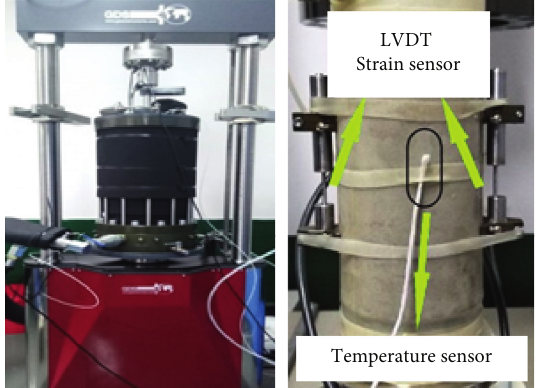
Figure 3: Static-dynamic triaxial axis instrument and sensor placement on the sample (developed by